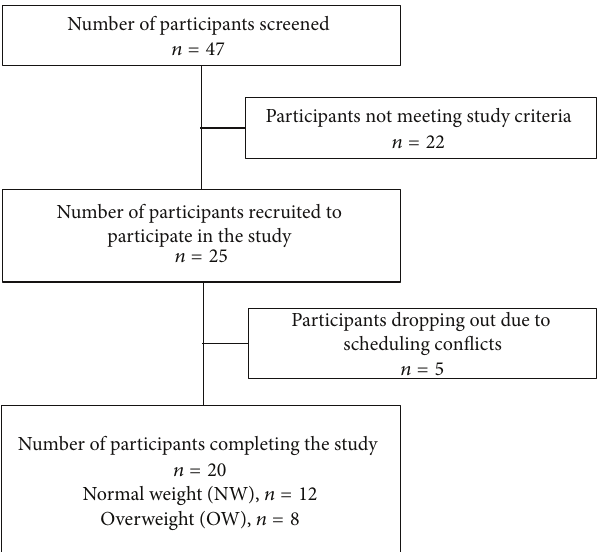
Figure 1: Flow diagram of the participant screening and selection